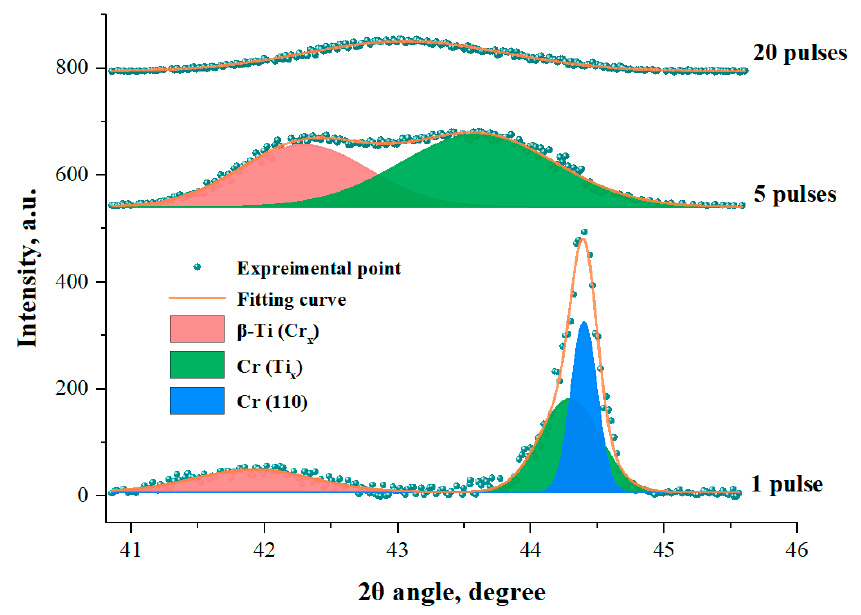
Figure 9. Local enlarged view of the XRD pa tt erns of the irradiated samples.